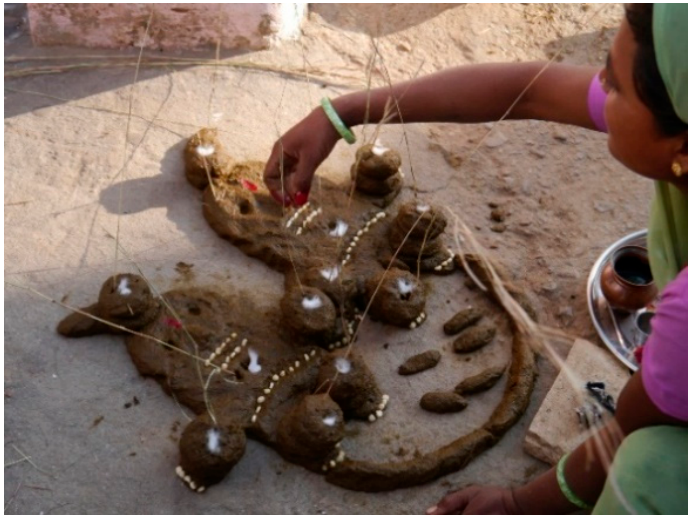
Figure 6. Two figures connected by a half circular strip of cowdung, Havala 2017 (picture by author).